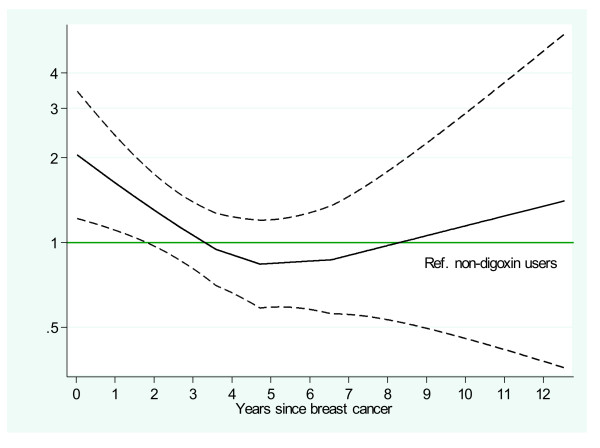
Estimated relapse hazard ratio (95% CI) for digoxin-exposed compared to unexposed (referent) women with breast cancer, adjusting for current age group and stratifying by protocol, protocol year, histological grade, node status, tumor size, and estrogen receptor status.